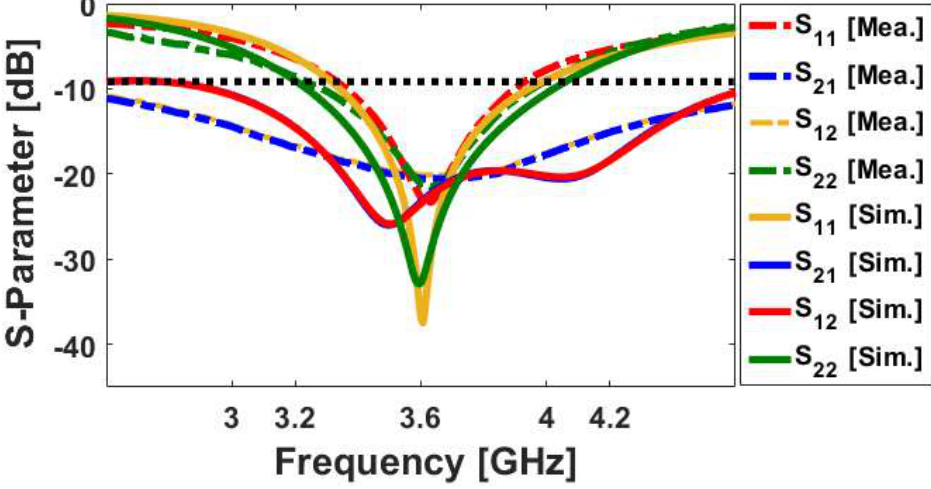
Figure 7. Photograph of the fabricated prototype in the measurement setup.